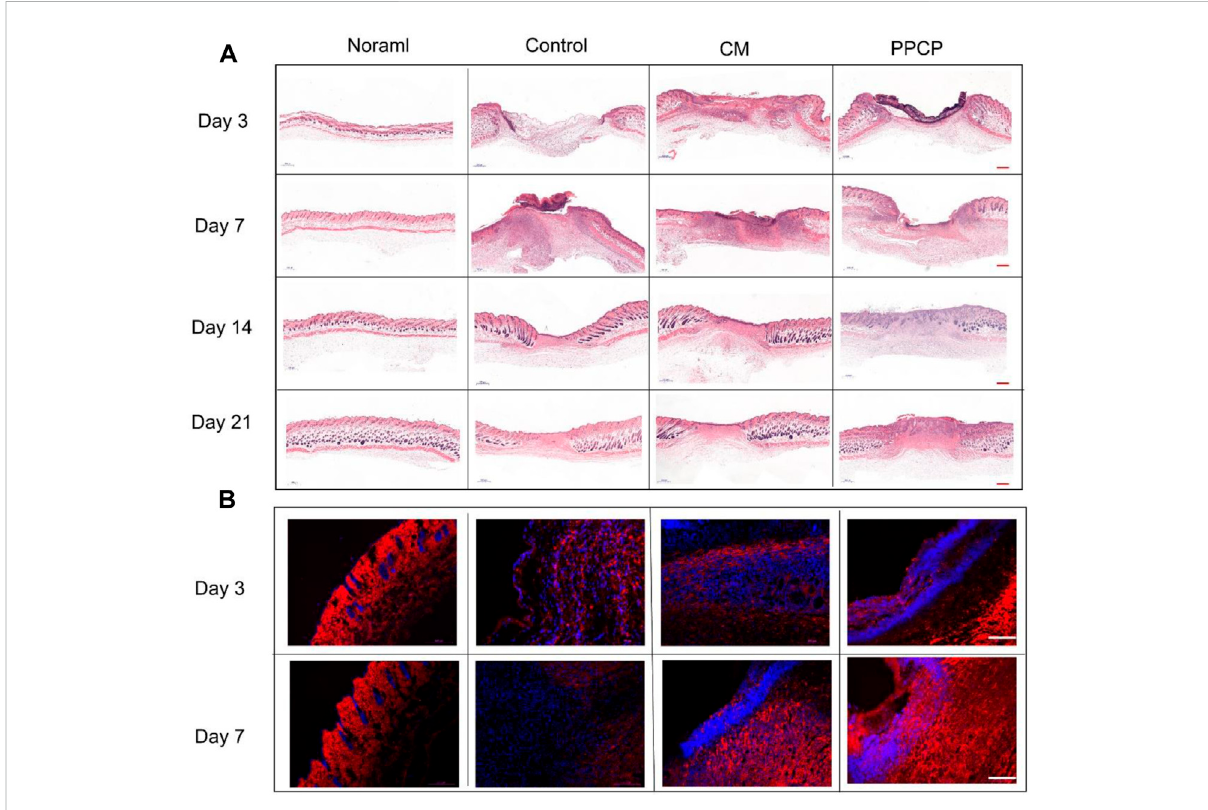
FIGURE 6 Picture of tissue stained with H&E and immuno fl uorescence. (A) H&E stained pictures of peri-wound skin tissue on days 3, 7, 14, and 21 after treatment (scale bar represents 500 μ m). (B) Representative immuno fl uorescence images of wound sections stained with collagen I of different treatment groups on days 3 and 7. (scale bar represents 100 μ m; blue represents nucleus and red depicts antibody